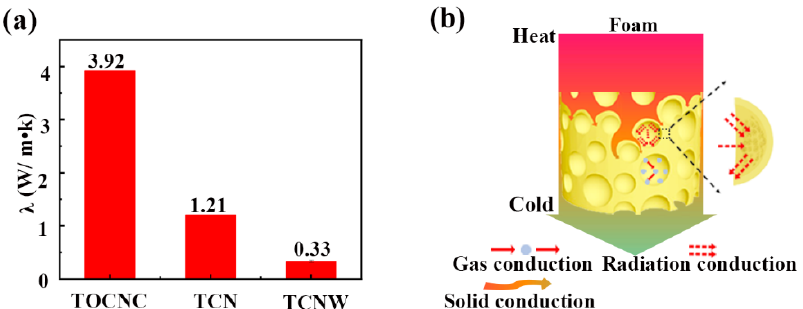
Figure 8. ( a ) Thermal conductivities of foams; ( b ) heat conduction in